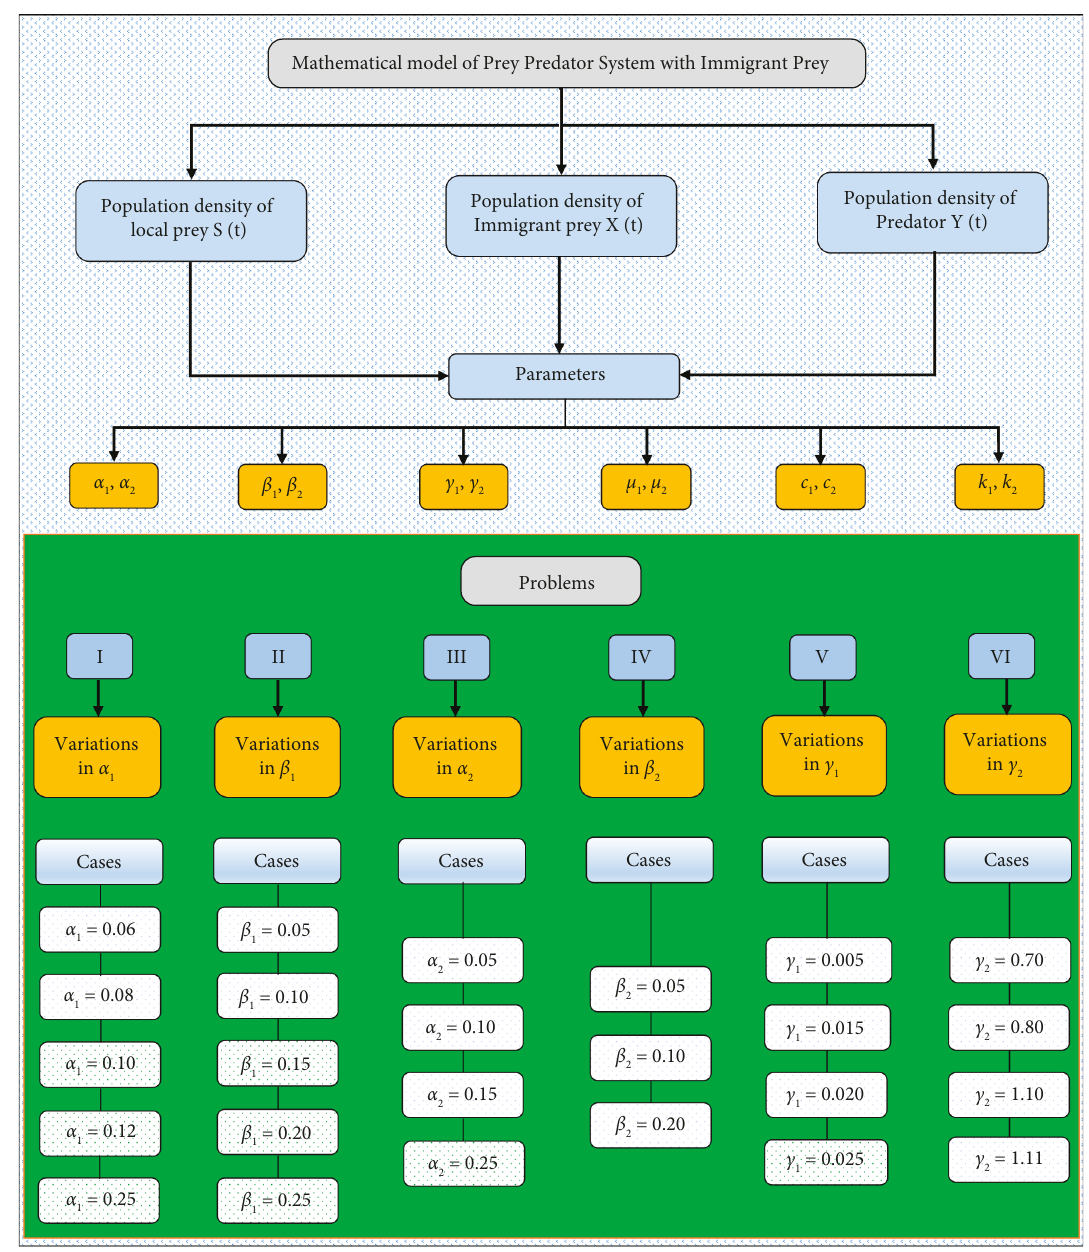
Figure 3: Graphical overview of the paper.